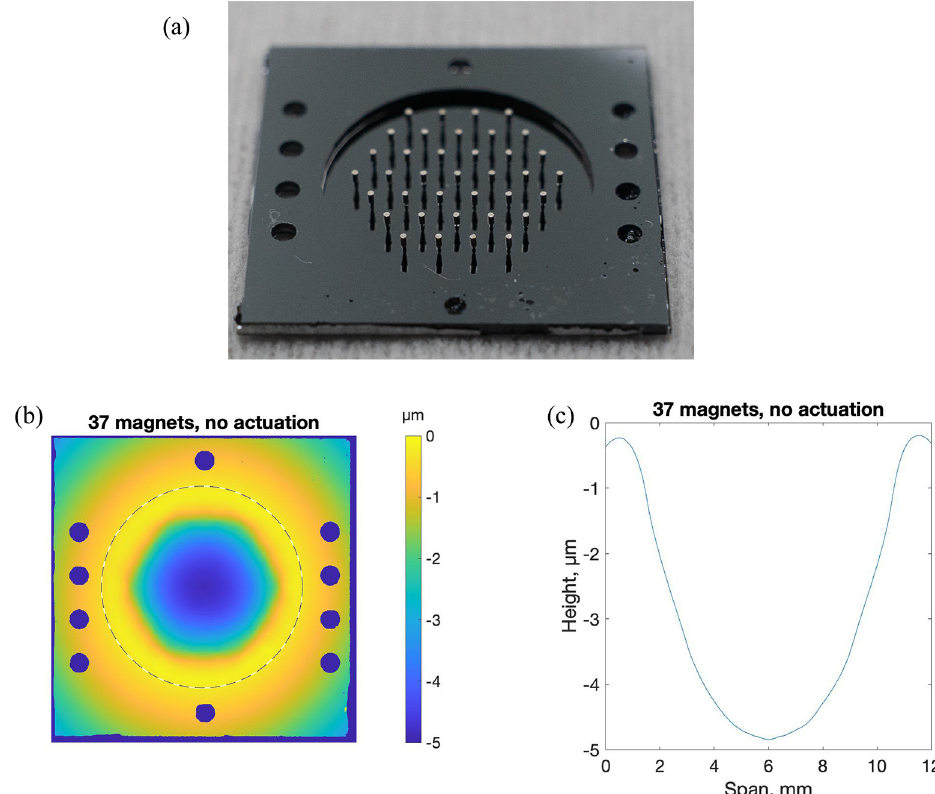
Figure 9. DM face sheet with posts and magnets attached. ( a ) Photo of SOI device showing the 18 mm square frame with guide holes for subsequent assembly with actuator electromagnetic coil array, the 12 mm diameter handle layer etch that exposed the 10 µ m thick face sheet, and the array of 37 posts etched out of the handle layer and attached to the face sheet through a thin silicon dioxide layer. ( b ) Surface topography maps of the face sheet after adhesive attachment of magnets. The dashed line marks the boundary of the face sheet. Nearly 5 µ m of deformation of the face sheet was observed, in a pattern bounded by the hexagonal shape of the periphery of the magnet array. ( c ) Plot of face sheet profile measured along the horizontal dotted line.